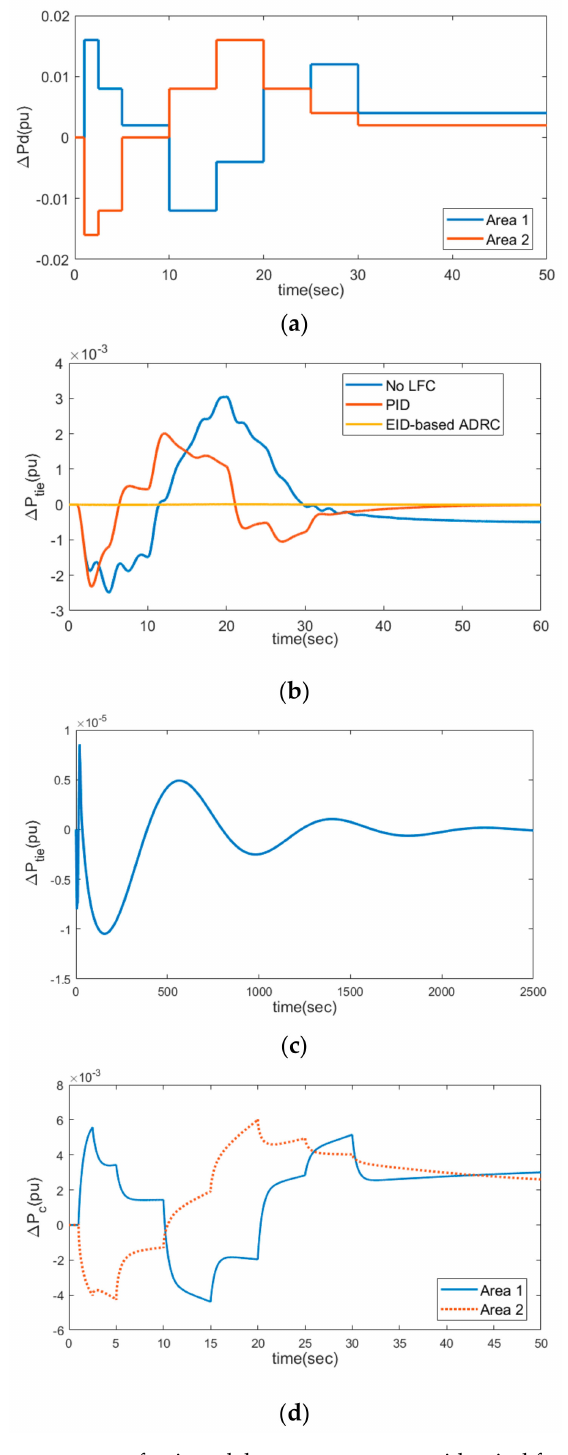
Figure 9. Tie-line power response of a time-delay power system with wind farm under random load, ( a ) load variation; ( b ) tie-line power deviation; ( c ) enlarged view under EID; ( d ) system control signals of EID-LFC under random load